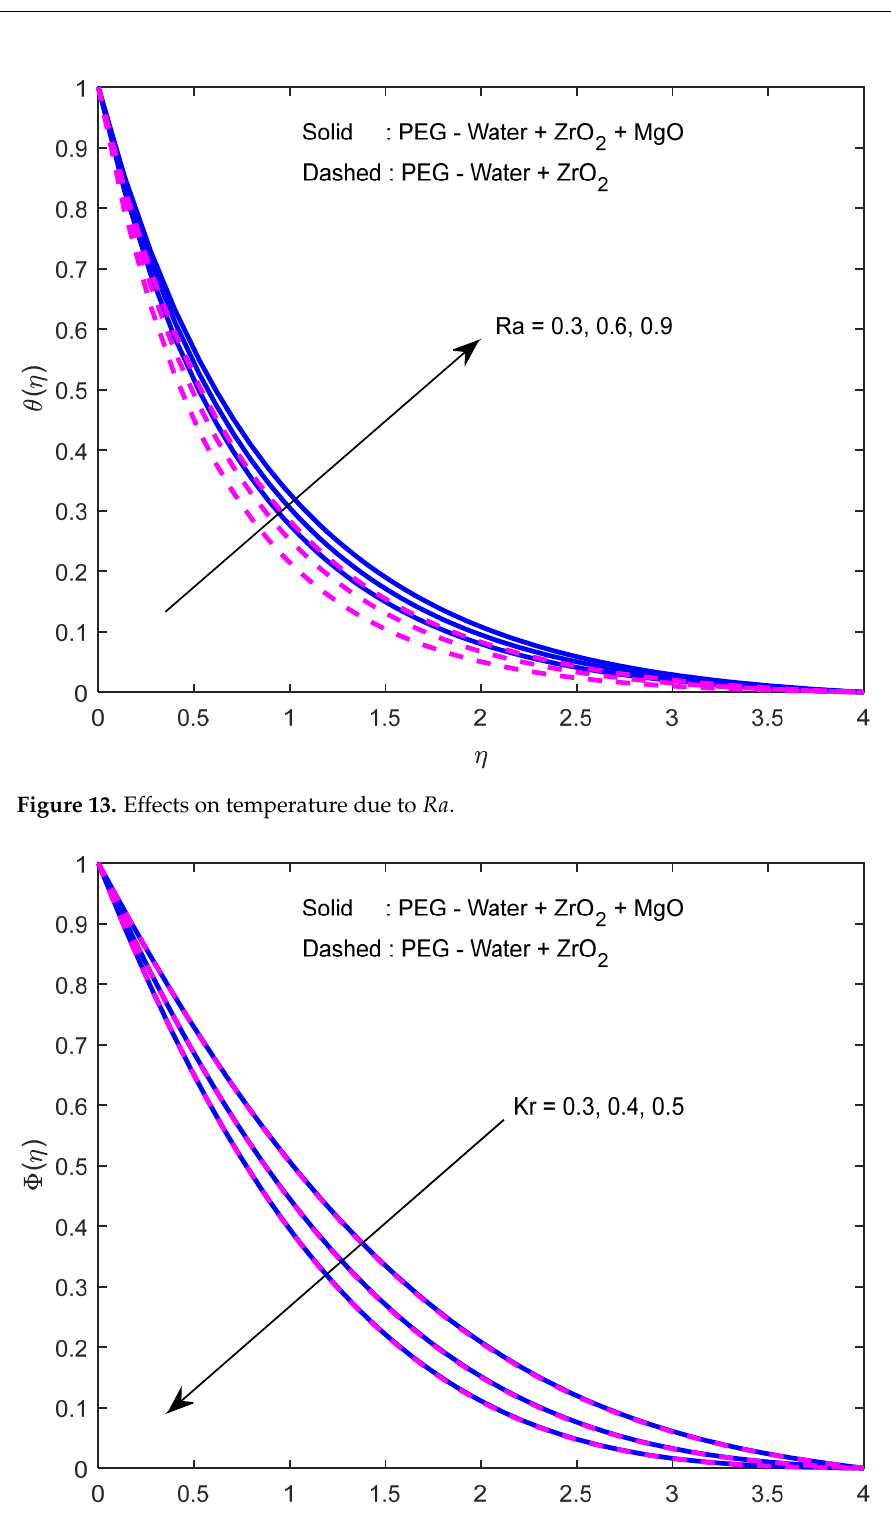
Figure 12. Effects on temperature due to